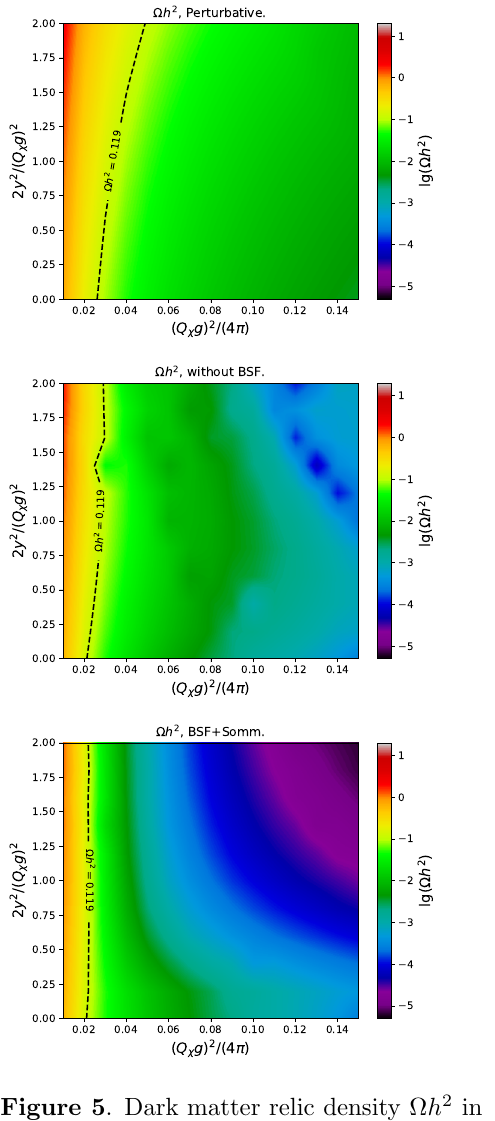
Figure 5 . Dark matter relic density (cid:10) h 2 in Figure 6 . m (cid:31) = 10 TeV. Other parameters h i (cid:0) 1 and the meaning of the three pannels are the (2 c 1 + c 2 ) 2 (cid:11) 0 the m (cid:31) = 3 TeV, (cid:24) 1 = 1 (cid:2) 1 : 03 2 same as (cid:12)gure 2 and (cid:24) 2 = 1 : 5 (cid:24) 1 situation. c 2 = ( Q (cid:31) g ) 4 (cid:25)(cid:11) 0 and c 1 = y 2 vary. The pannels are c 2 ( Q (cid:31) g ) 2 the tree-level perturbative results, the Sommerfeld results, and the bound state formation e(cid:11)ects included results from up to down, respectively.